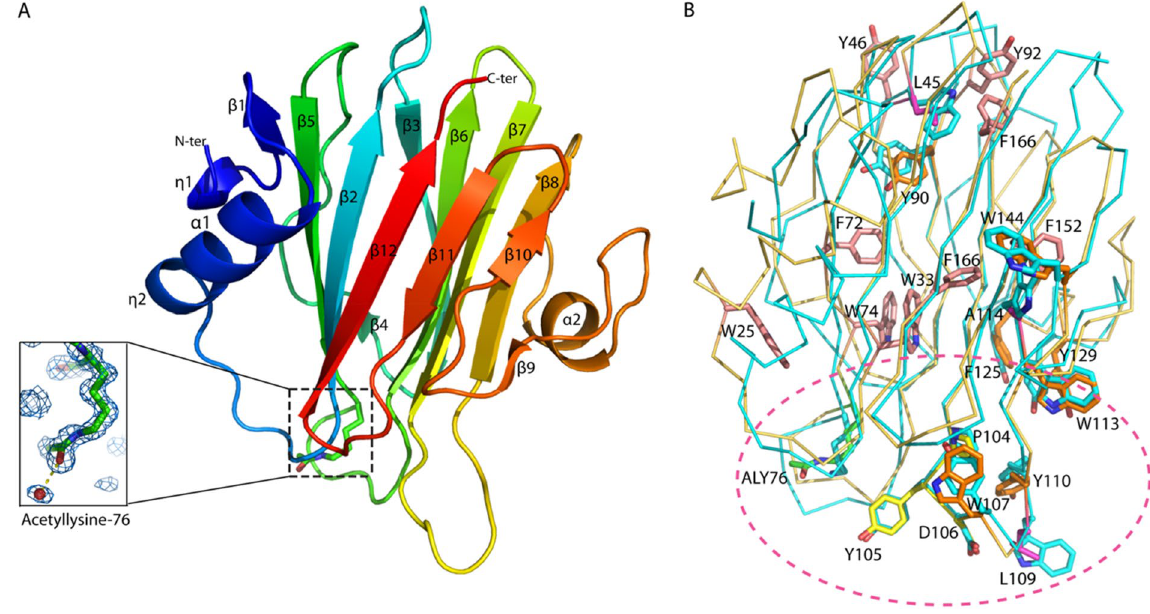
Figure 2. Overall crystal structure of recombinant HALT-1 protein. ( A ) The rHALT-1 consists of β sandwich fold with 12 β-strands and two α-helices and two 3 10 helices on the sides, which assembles a pore-forming toxin (PFT). The 2Fo-Fc maps for acetylated lysine residue 76 are contoured at 1.0 σ. ( B ) Superimpose of HALT- 1 (brown) and AfFraC (PDB ID: 4TSQ_A) (cyan). The aromatic residues that are found conserved in HALT proteins are shown in light pink stick and aromatic residues that are found conserved in both Hydra and sea anemone toxins are shown in orange stick. Residues L45, L109, and A114 in HALTs are shown in pink stick. They are variants to aromatic residues found in sea anemone toxins that are important for haemolytic activity and sphingomyelin membrane binding. A P-[W/Y/F]-D motif that is conserved in HALTs and sea anemone, which are known to interact with lipid molecule of membrane are shown in yellow stick. The structure AfFraC with conserved sea anemone aromatic residues are shown in cyan sticks. The dash line circle represents the general lipid-binding region. All the residues numbering are referred to HALT-1. The figures were generated using the program PyMOL (version 2.5.2 Schrödinger,